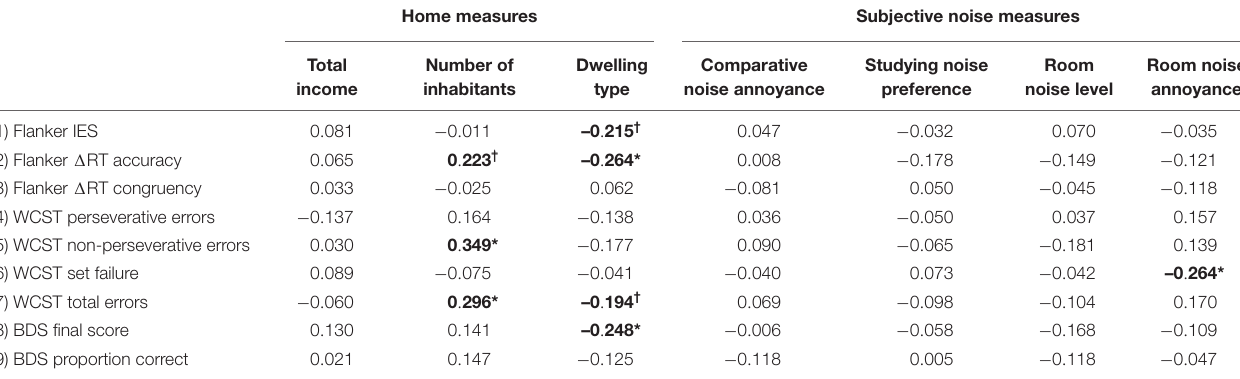
TABLE 4 | Correlations of task scores with home measures and subjective measures of